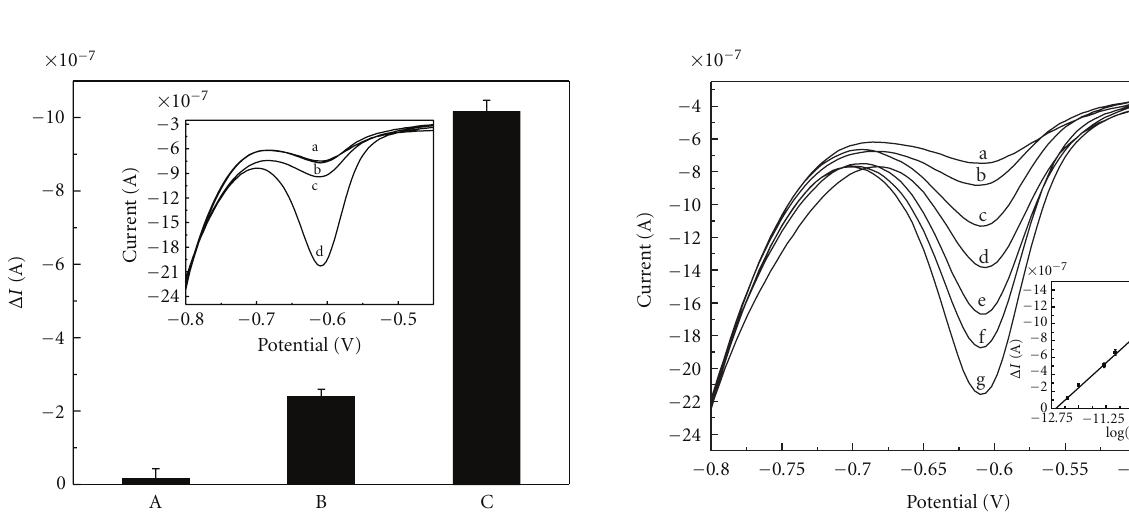
Figure 6: DPV response of the intercalated adriamycin recorded for the probe DNA modified electrode that hybridized with various concentrations of complementary DNA: (a) 0M; (b) 5.0 × 10 − 13 M; (c) 1.0 × 10 − 12 M; (d) 5.0 × 10 − 12 M; (e) 1.0 × 10 − 11 M; (f) 1.0 × 10 − 10 M; (g) 1.0 × 10 − 9 M. Inset: Peak current ( Δ I ) of the intercalated adriamycin versus logarithm of concentration of complementary DNA. Error bars show the standard deviations of measurements taken from three independent experiments. Accumulation time of adriamycin: 20min; hybridization time: 25min. The DPV parameters were the same as in Figure 2(B). complementary DNA and found that the fifth regenerated sensor has 84.7% response of the initial sensor (initial: 1.24 × 10 − 6 A, final: 1.05 × 10 − 6 A). This result indicated the proposed DNA biosensor had a good